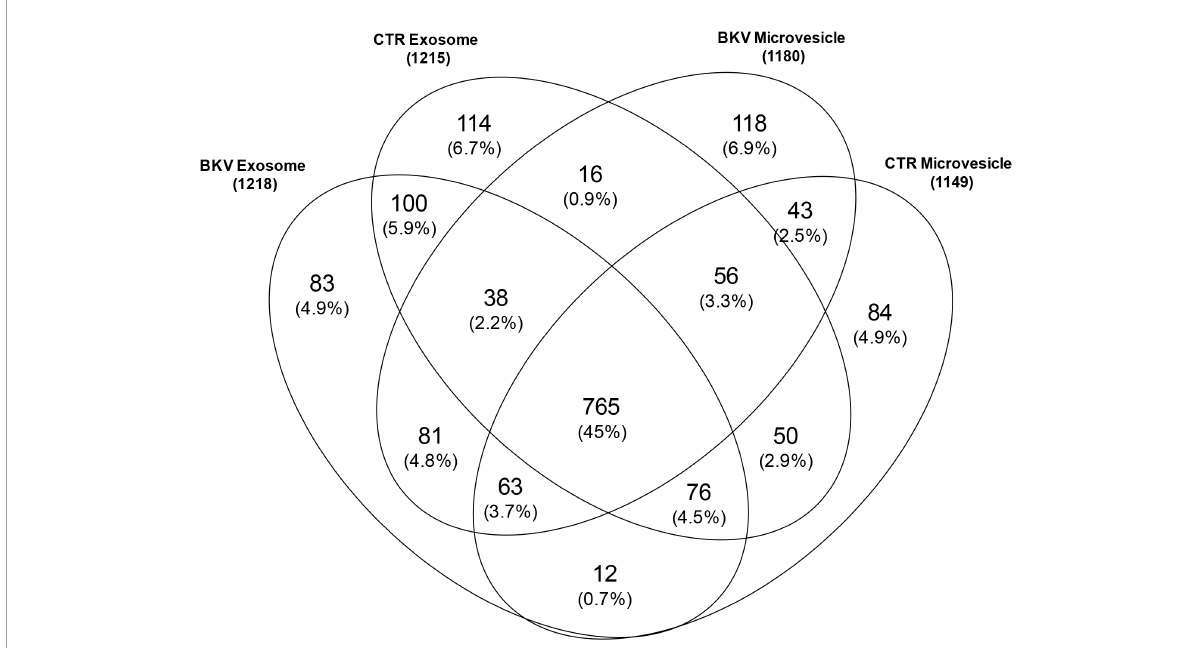
FIGURE1 Venn diagram of total proteins identified in urinary microvesicles and exosomes of patients with BKV infection and patients with no infection (CTR). The diagram shows common and exclusive proteins in 12 patients with BKV infection and 6 CTR by mass spectrometry. The numbers (and percentages) of proteins in the overlapping and non-overlapping areas are indicated. Overall, 118 and 83 proteins were unique for microvesicles and exosomes in patients with BKV infection. In the CTR group 84 and 114 proteins were unique for the microvesicles and exosomes,